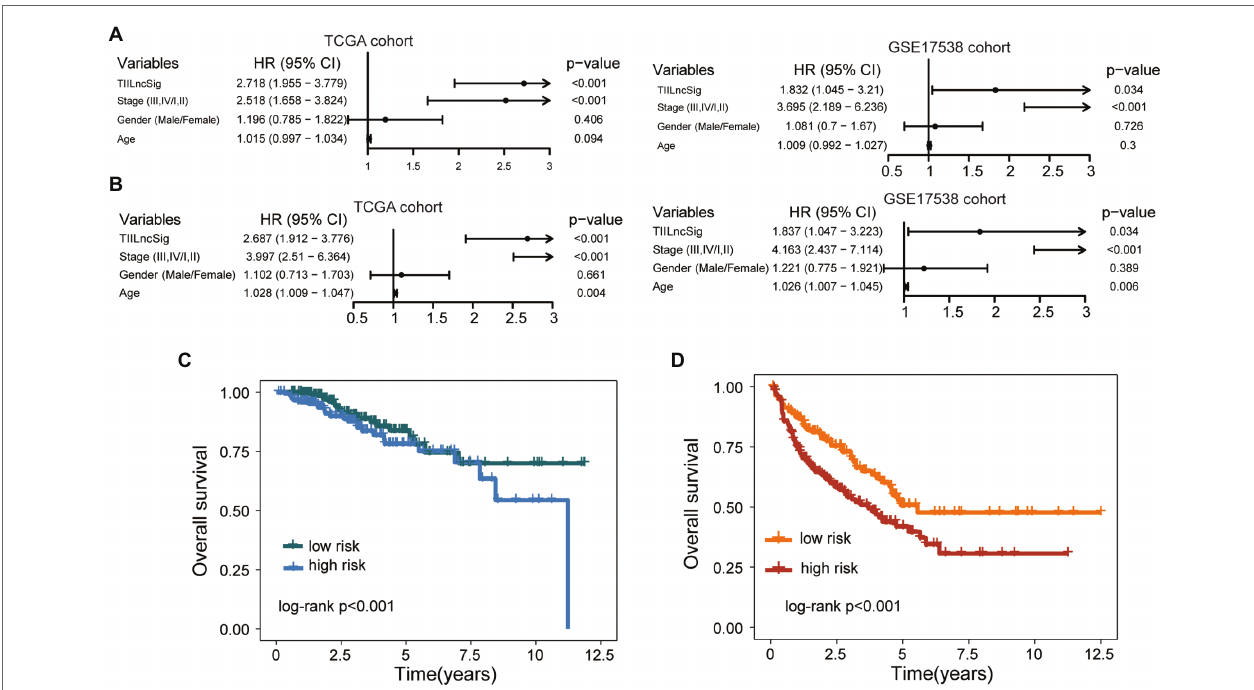
FIGURE 4 | Independence of the TIILncSig from other clinical features. (A) Univariable Cox regression analysis of the TIILncSig and other clinical features with overall survival in each cohort. (B) Multivariable Cox regression analysis of the TIILncSig and other clinical features with overall survival in each cohort. (C) Kaplan- Meier survival curves of overall survival between high- and low-risk groups for patients with stage I and II. (D) Kaplan-Meier survival curves of overall survival between high- and low-risk groups for patients with stage III and